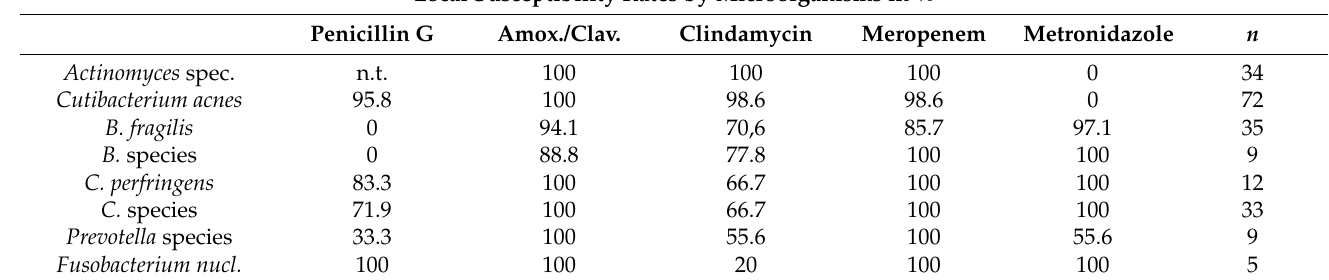
Table 4. Anaerobic strains that were cultured by the local microbiology department since 2014 and their antibiotic susceptibility